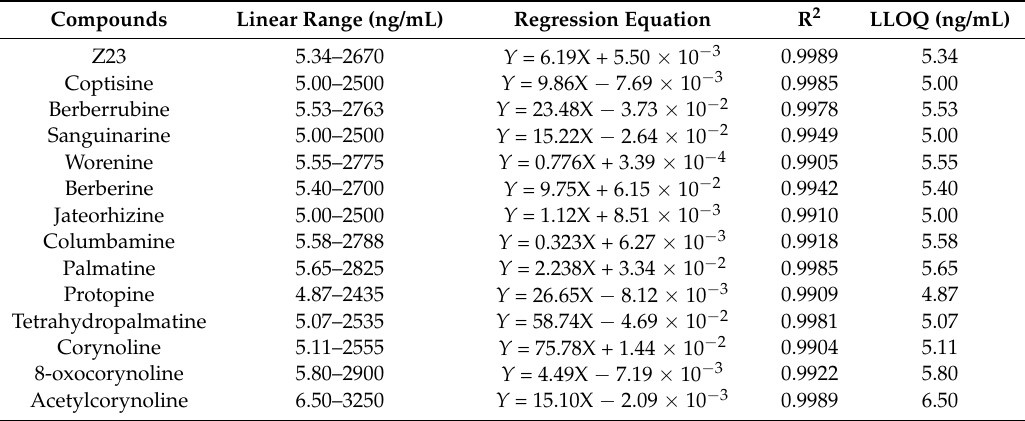
Table 1. The regression equations, linear ranges and LLOQs for the determination of the analytes in beagle’s plasma.